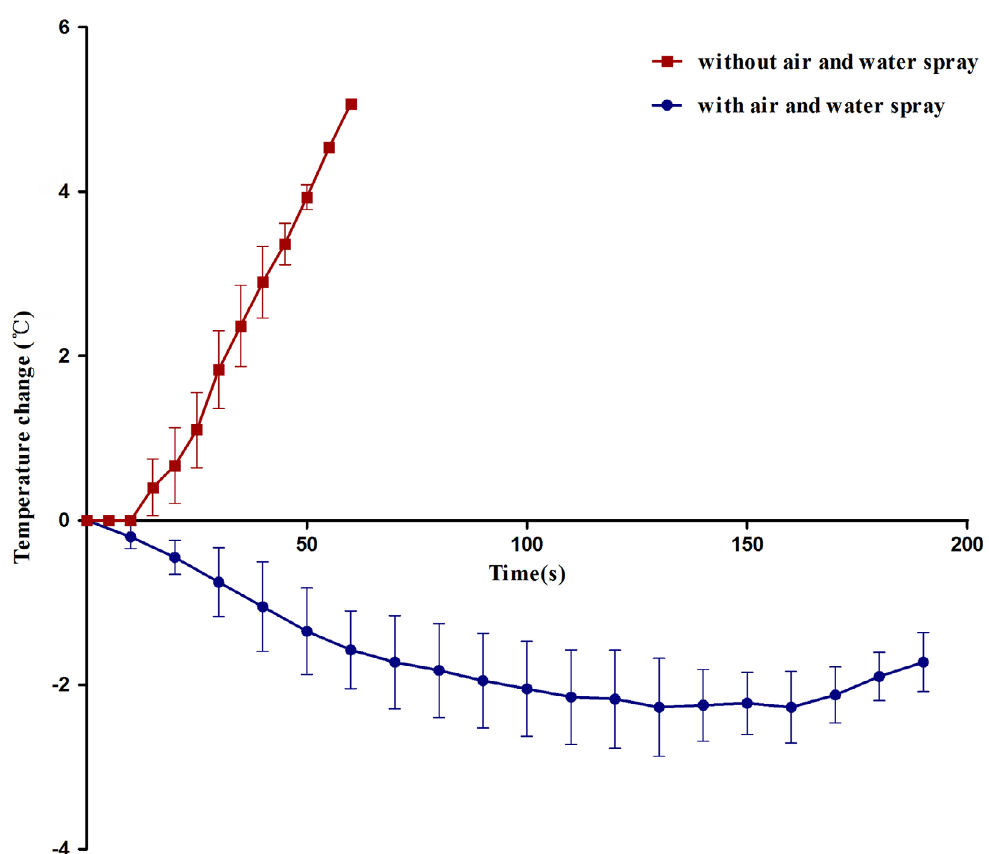
Figure 5- Intrapulpal temperature change during Er:YAG laser irradiation (0.5 W , 167 J/cm 2 ) with and without air and water spray